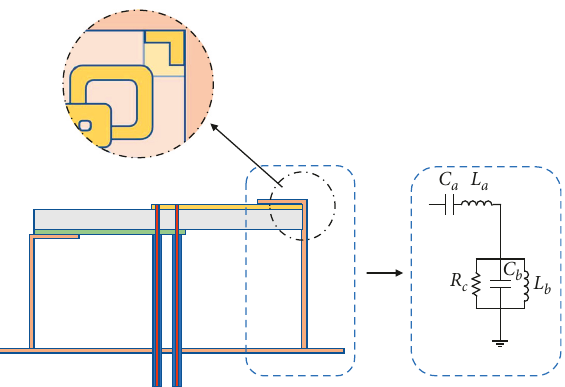
Figure 9: Equivalent circuit diagram of parasitic